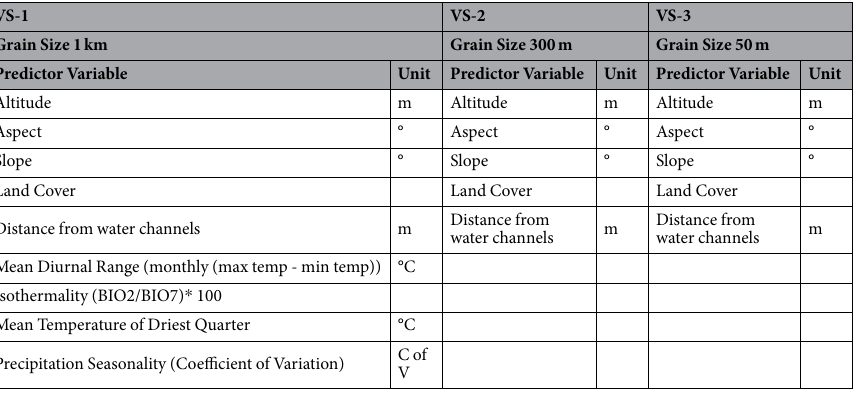
Table 1. Predictor variables used in the study. Acronyms VS-1, VS-2 & VS-3 refer to variable set 1, variable set 2 & variable set 3